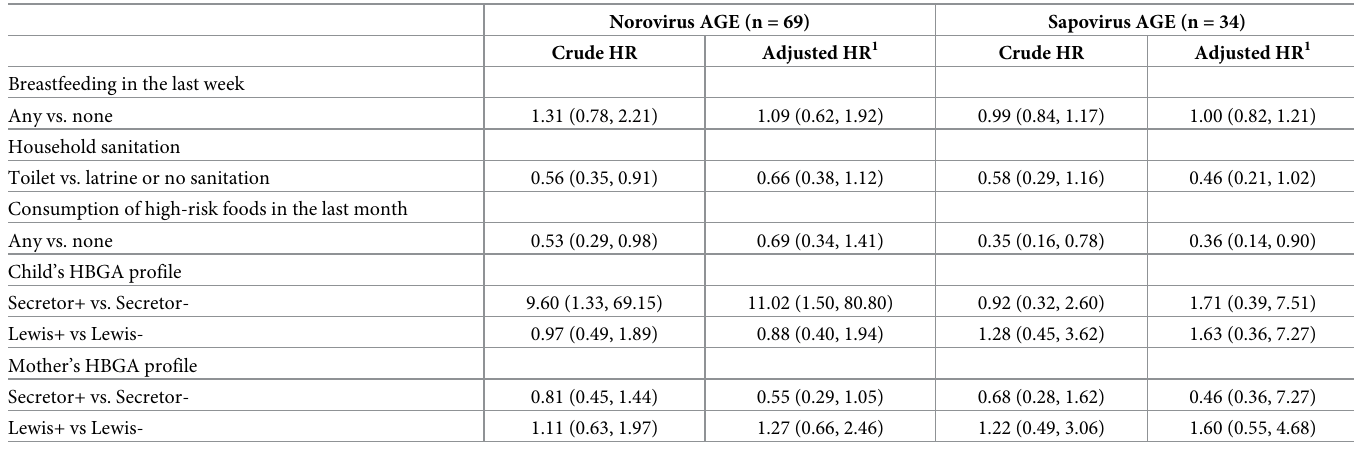
Table 3. Crude and adjusted relative hazards between breastfeeding and norovirus and sapovirus AGE in first 12 months of